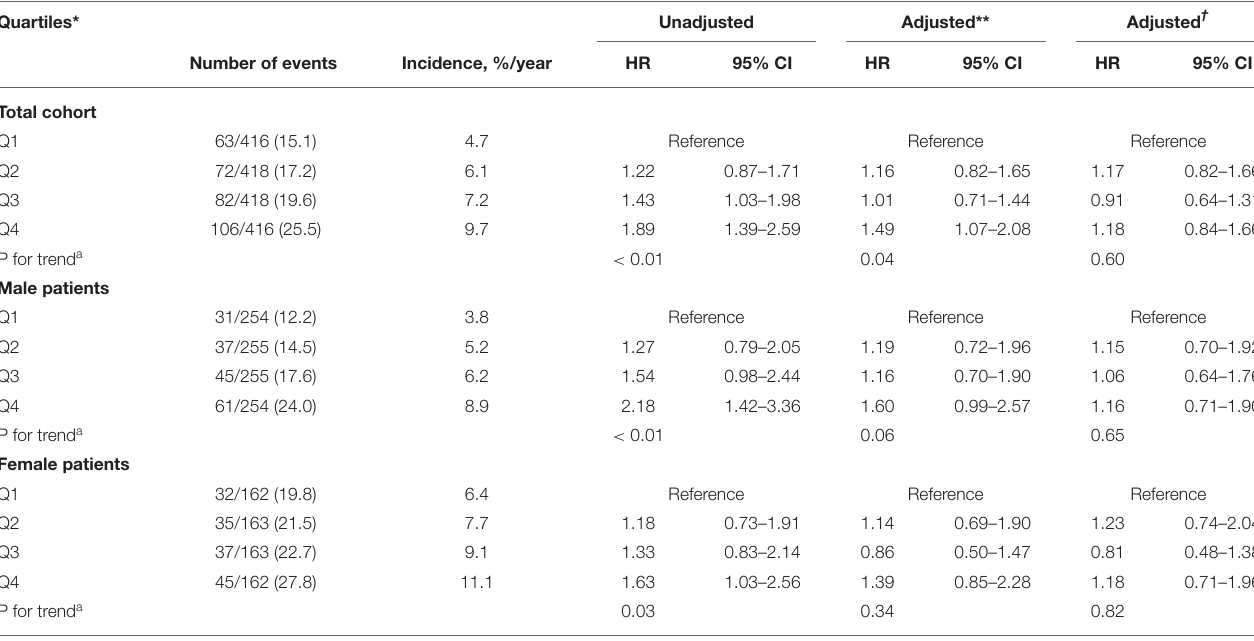
TABLE 2 | Annual incidence rate and unadjusted and adjusted hazard ratios for quartiles of sex-specific QTc intervals predicting clinical outcomes during the 6-year follow-up period.